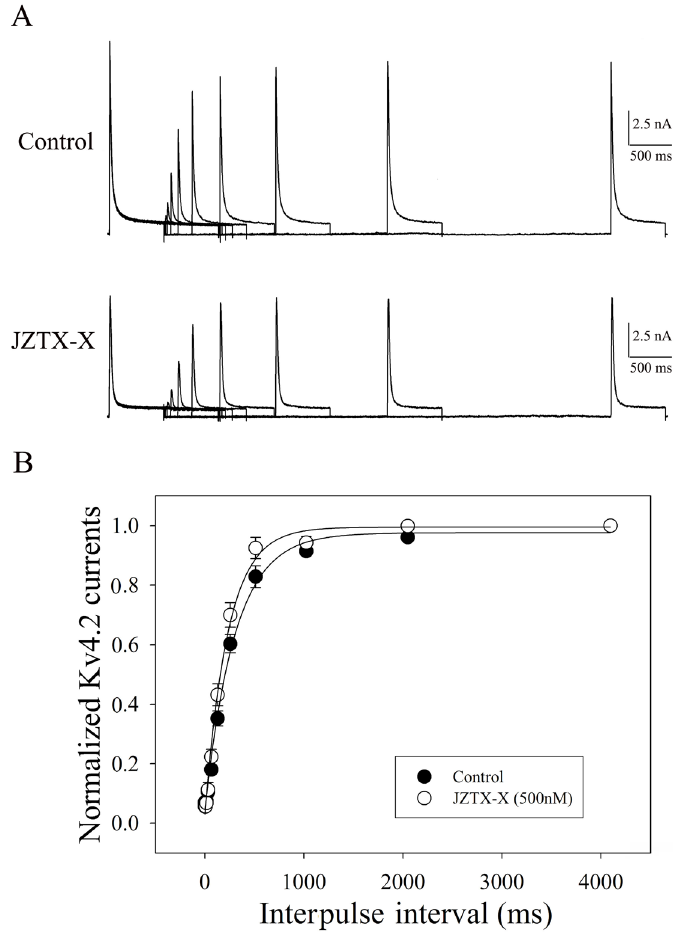
Figure 7. Effects of JZTX-X on the inactivation recovery time course of Kv4.2 channels. (A) The two-pulse protocol was applied to record the typical current traces with or without JZTX-X treatment. First of all, the initial 700 ms depolarization pre-pulse was applied at +20 mV from the holding potential of -80 mV, and then the second same pulse was applied at −80 mV when the interpulse intervals were between 0.5 ms and 4096 ms. Thereafter, those elicited peak currents in test pulses were determined and standardized based on the peak currents for conditioning pulses within the identical cell. The first record in each row is the ‘conditioning pulse’ employed to normalize the other records, and the last one is a ‘control’ utilized to confirm the full recovery of channel current. (B) The standardized recovery data were expressed as mean ± S.E. (n = 7), plotted as a function of inter-pulse interval, and fitted to one singular exponential